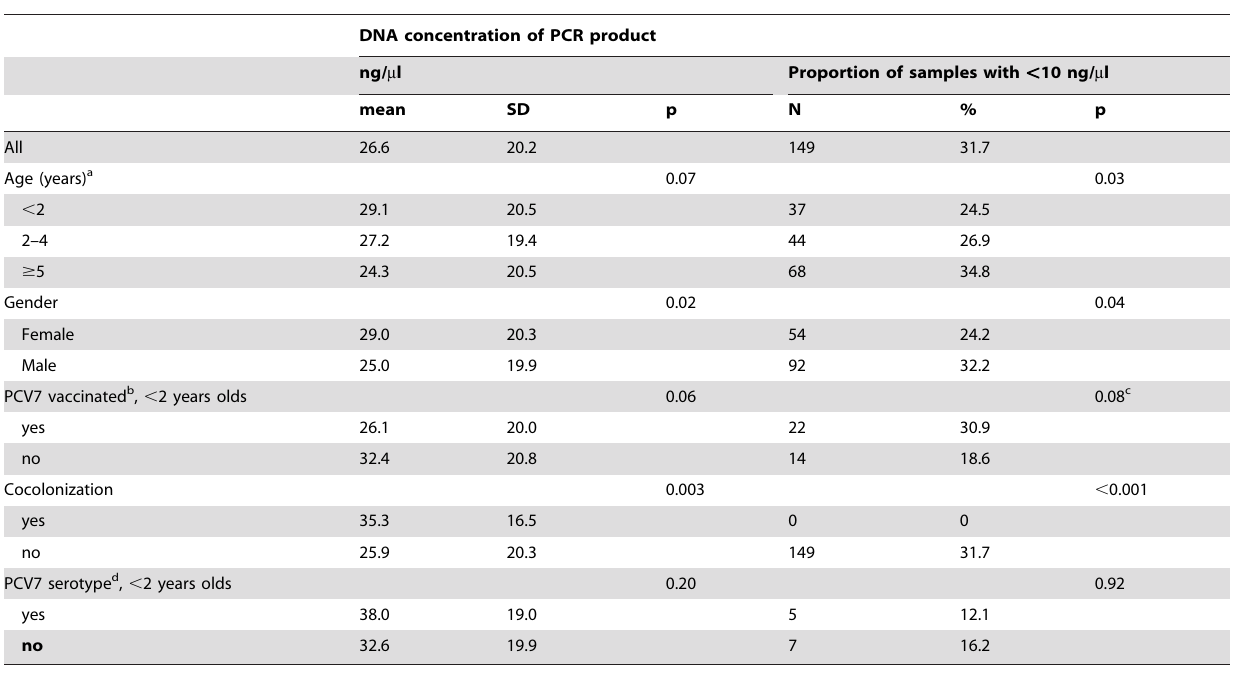
Table 2. Univariate analysis of DNA quantity of plyNCR PCR products as a surrogate for pneumococcal colonization density in the